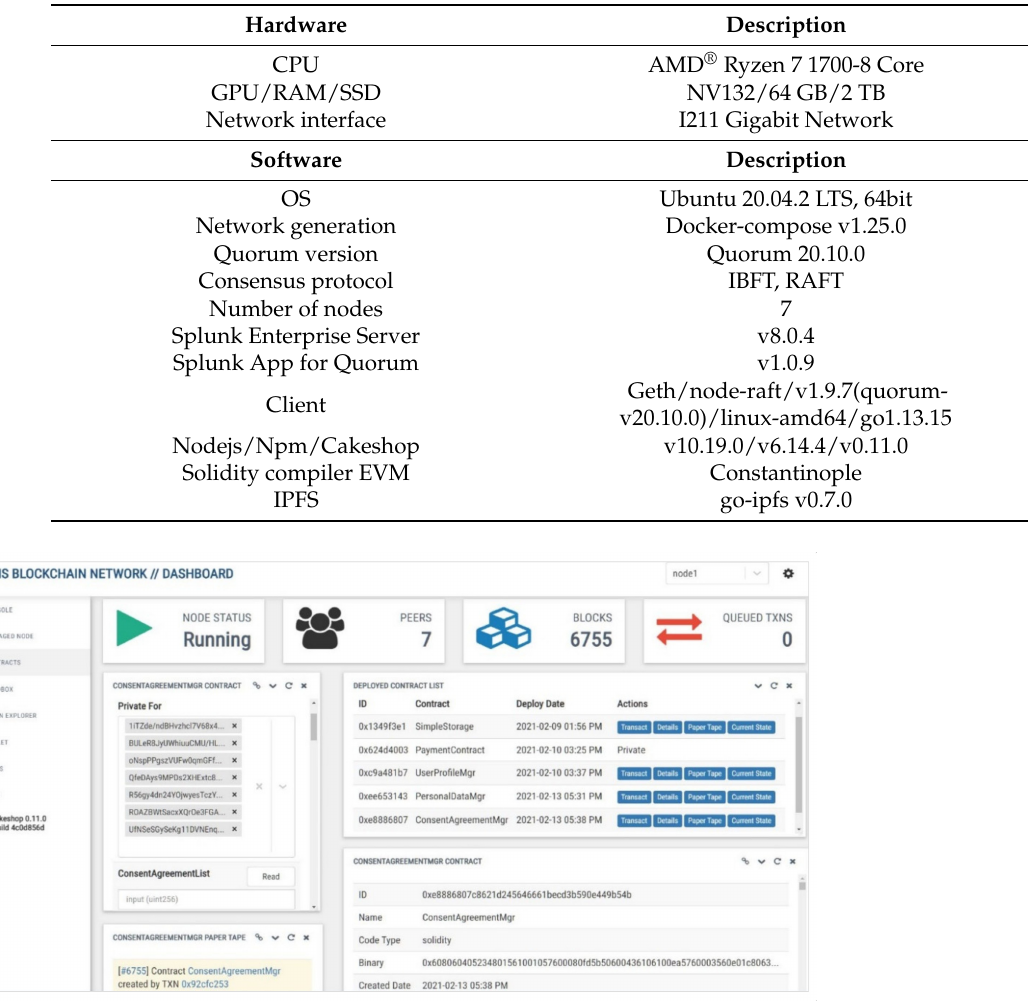
Figure 6. SC-DCMS consortium blockchain network management dashboard using